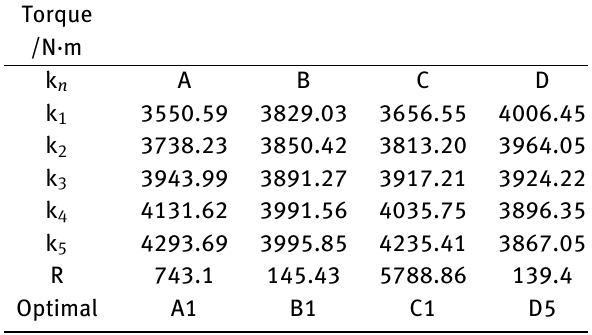
Table 4: Torque of orthogonal results